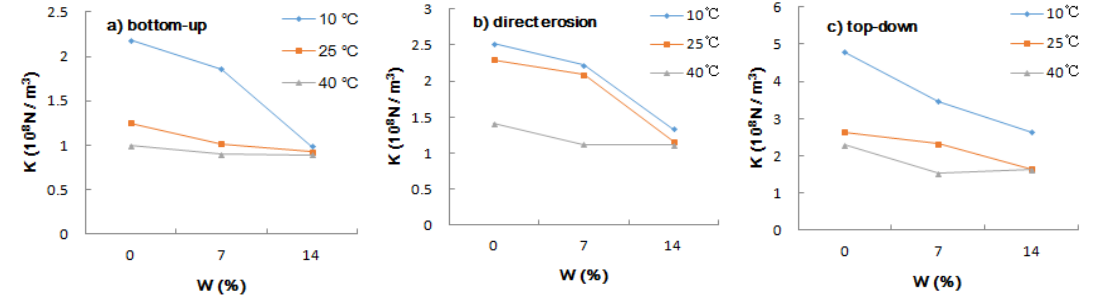
Figure 6. Effect of salt solution concentration on interlaminar shear modulus: ( a ) bottom-up; ( b ) direct erosion; ( c ) top-down.